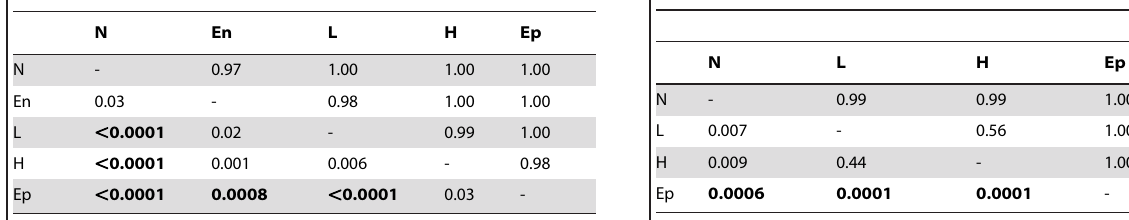
Table 3. Structural gene substitution rate variation among viruses with different cell tropisms. Table 4. Non-structural gene substitution rate variation among viruses with different cell